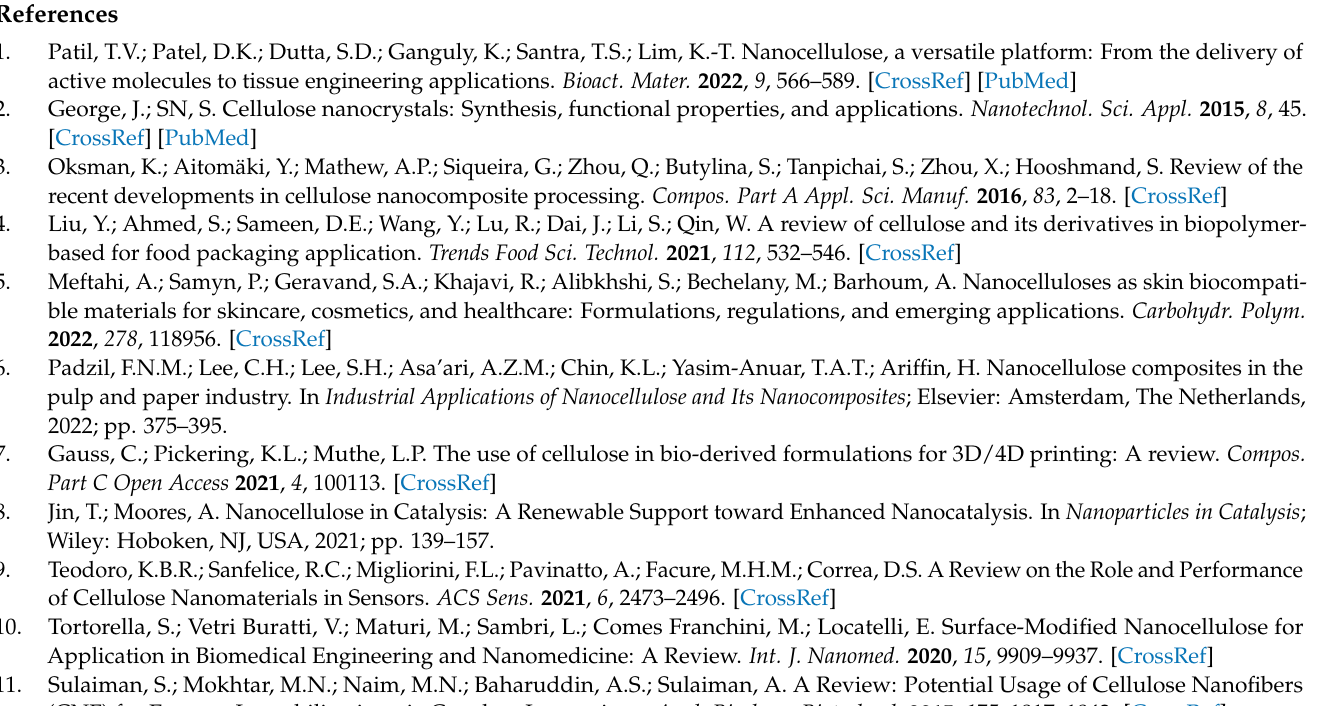
Figure S2: 1 H-NMR (600 MHz, Chloroform- d ) of pyta-COOH and pyta-CH 3 . Figure S3: Emission maps of MCC-Ir. Figure S4: SEM image of MCC-OH; Table S1: Fitting parameters for the double exponen- tial decay of phosphorescence intensity during the photostability experiment on MCC-Ir powder and [Ir(ppy) 2 (pyta-COOH)]Cl in PMMA, according to Equation